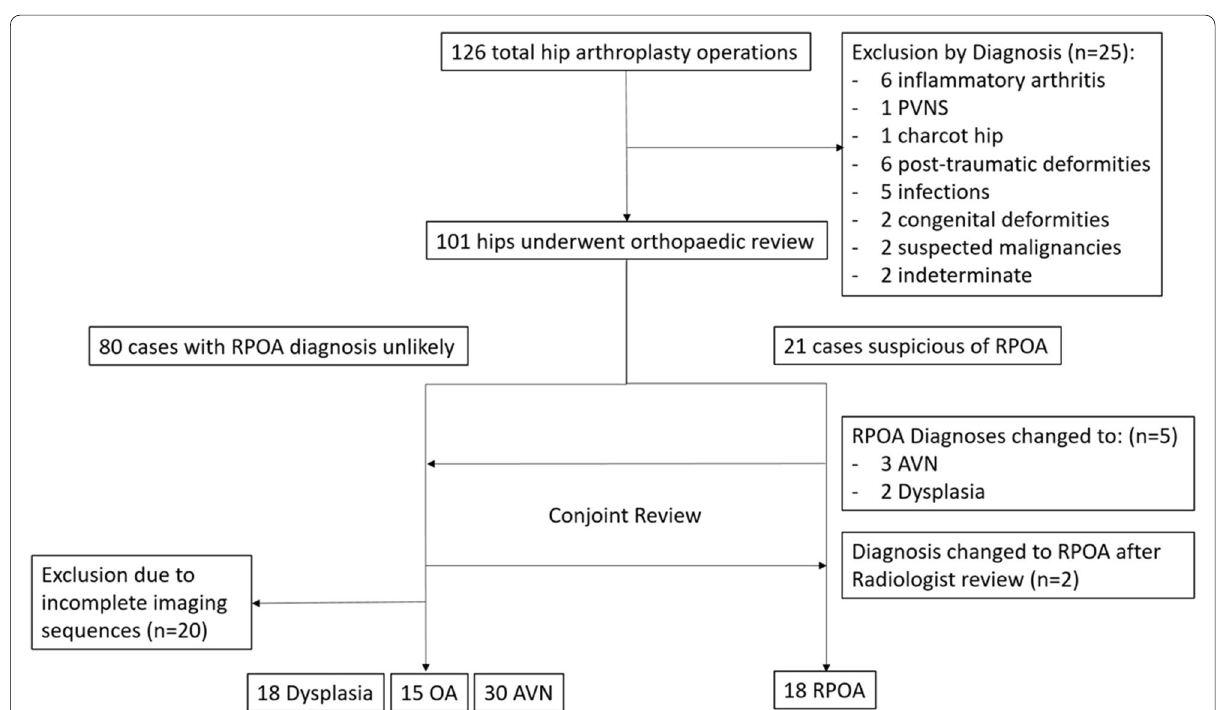
Fig. 3 The flow diagram showing 126 pre operative images of hip arthroplasty operations reviewed. RPOA: Rapidly progressive osteoarthritis. OA: primary osteoarthritis. AVN: avascular necrosis. PVNS: pigmented villonodular synovitis